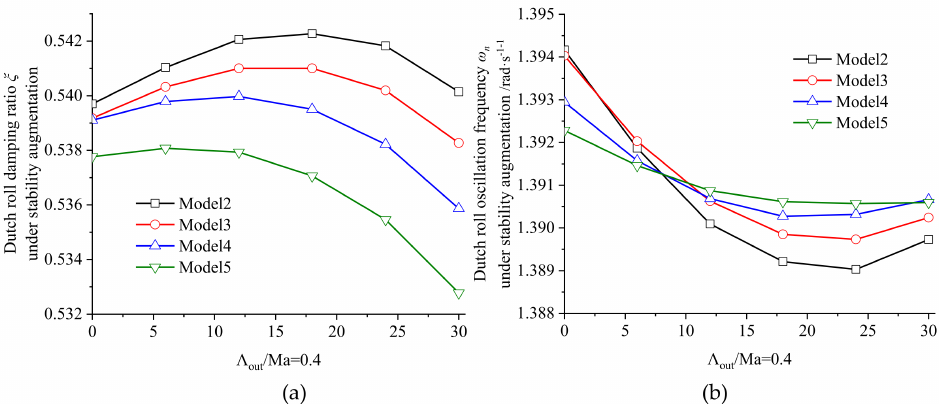
Figure 16. The damping ratio ξ and the oscillation frequency ω n of the Dutch roll modal of the pre-selected models after the stability augmentation adjustment with Λ out corresponding to the configurations when Ma = 0.4. ( a ) Damping ratio ξ , ( b ) oscillation frequency ω n